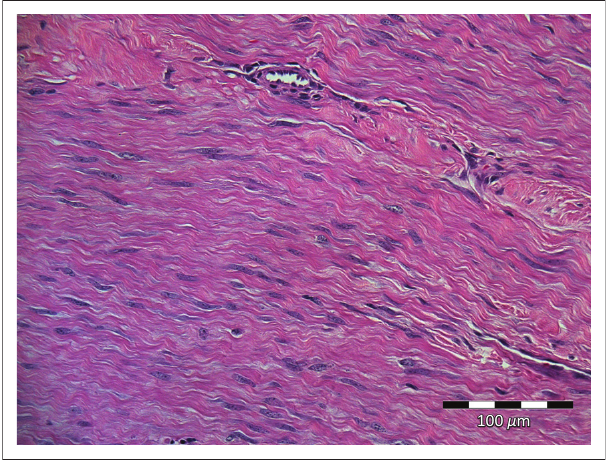
FIGURE 1: A photomicrograph showing the fibrous connective tissue of the mass in longitudinal section with elongated wavy collagen fibrils and nuclei. (H&E × 400).